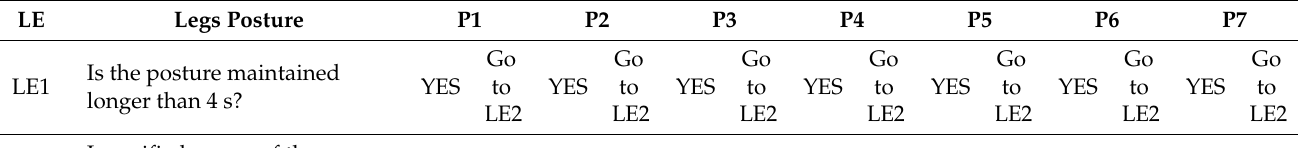
Table A5. Legs posture